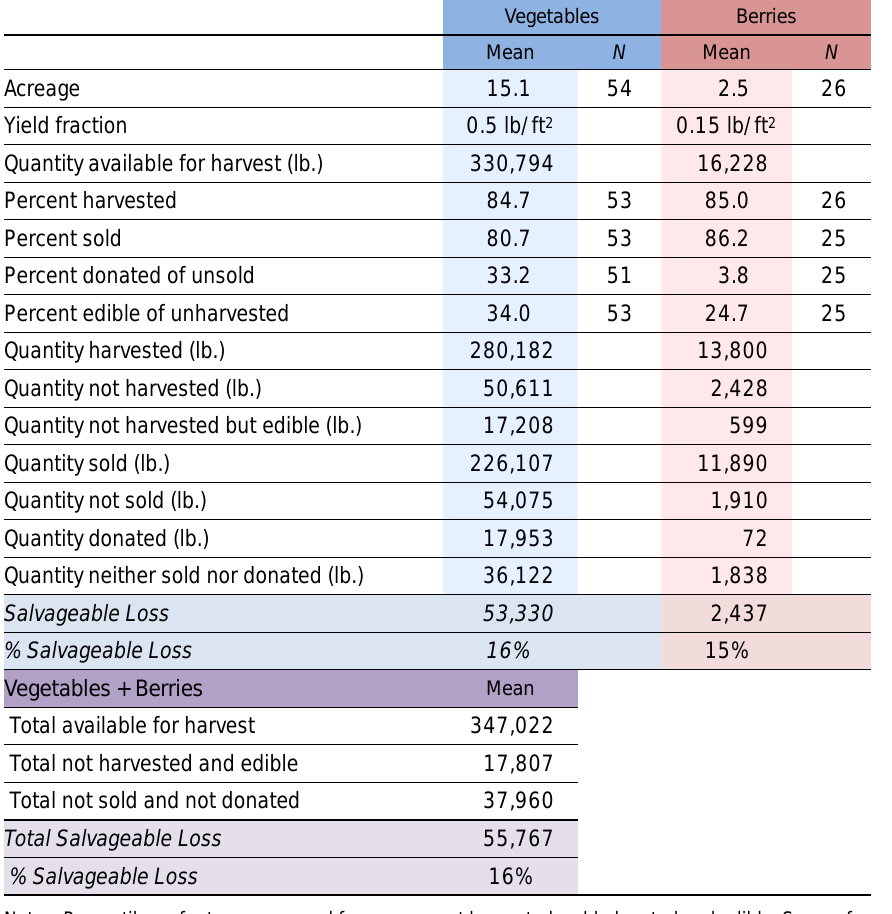
Table 3. Estimated Salvageable Loss of Vegetables and Berries on Sampled Farms in Vermont, 2016, Based on Estimated Quantities Lost, Sold, and Donated: Mean